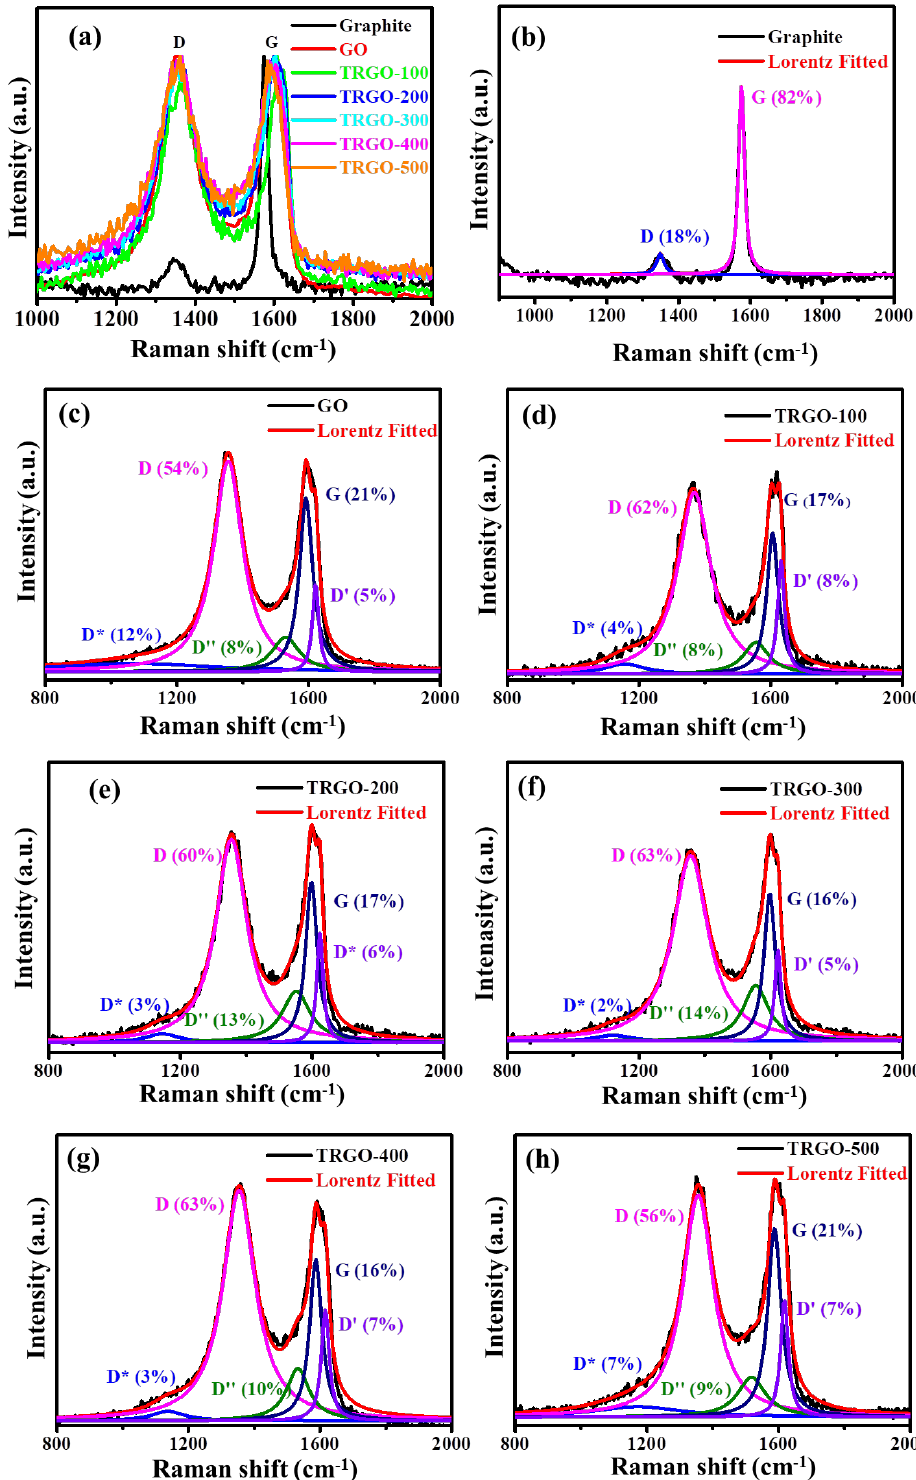
Figure 5. Raman spectra intensity of graphite, GO, and TRGO-100 to TRGO-500. One-phonon region of the Raman spectra of ( a ) graphite, ( b ) GO, and ( c – h ) TRGO-100–TRGO-500, plotted together with the best fit (R 2 > 0.95 and ꭕ 2 < 100) of the experiment to the sum of the five components (D*, D, D ′′ , G, and D ′ ).